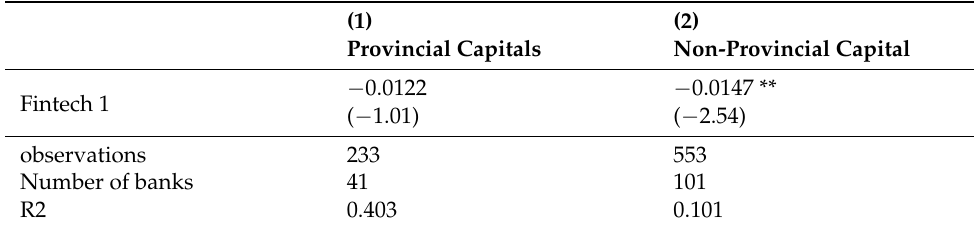
Table 10. Heterogeneity test between provincial capital cities and non-provincial capital cities.